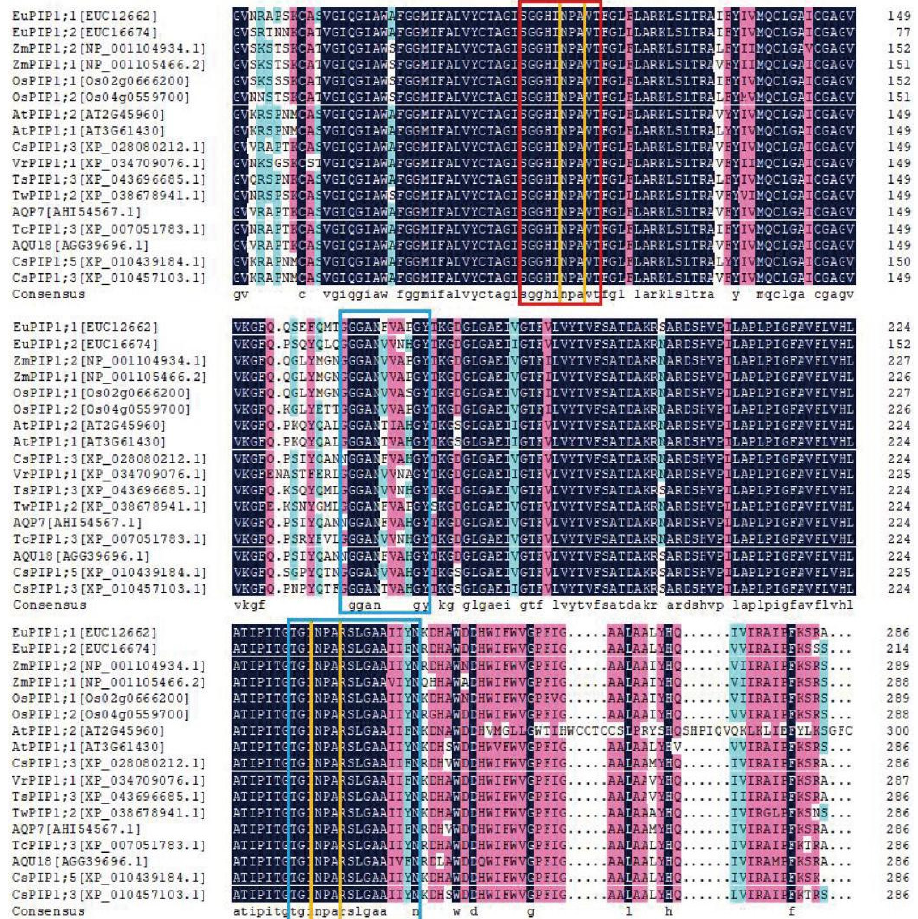
Figure 2. Multiple alignment analysis of EuPIP1;1 with other species of PIP proteins. The intrinsic protein-specific motif of the MIP family ‘SGGHINPAVT’ is enclosed in the red box, the highly conserved sequences of the PIP of plants ‘GGGANVVNPGY’ and ‘TGINPARSLGAAIIYN’ are indicated in blue boxes, and two ‘NPA’ motifs are enclosed in orange boxes.